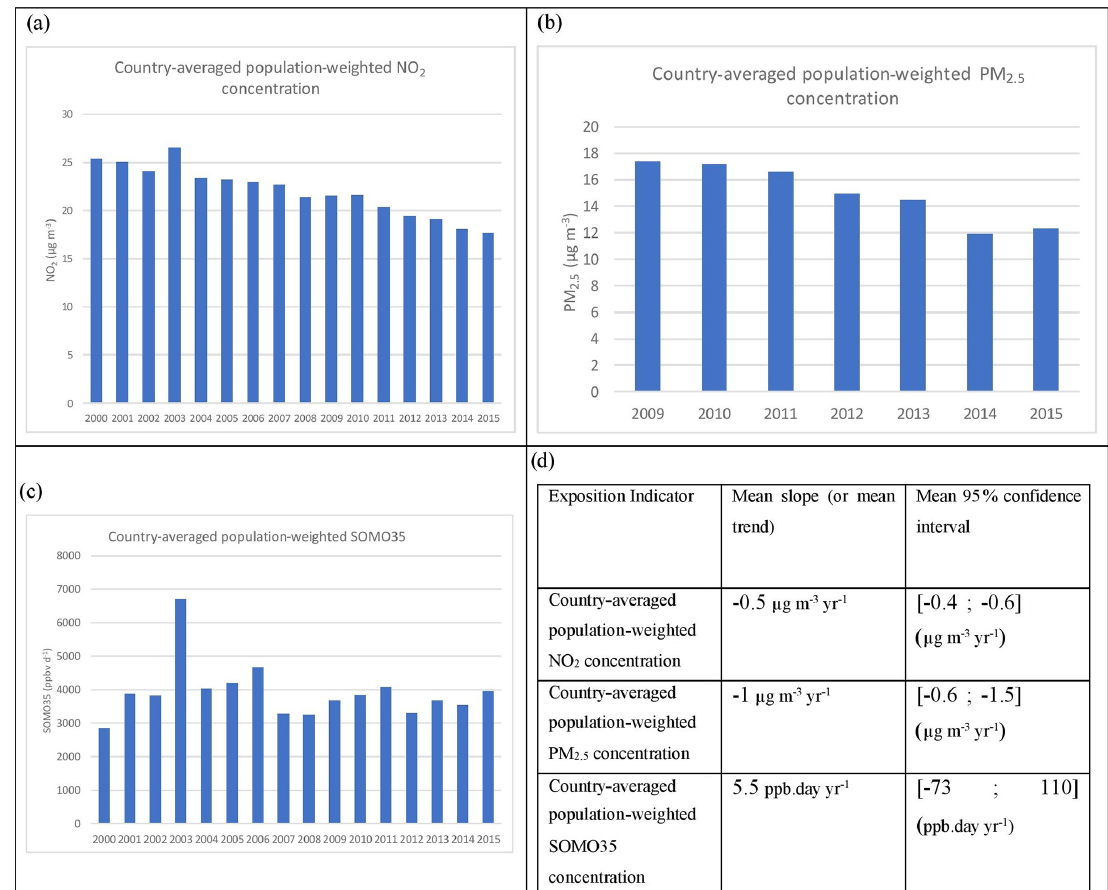
Figure 17. Yearly evolution of the country-averaged population-weighted (a) NO 2 concentration, (b) PM 2 . 5 concentration and (c) SOMO35. Trends and 95% confidence intervals are calculated (d)